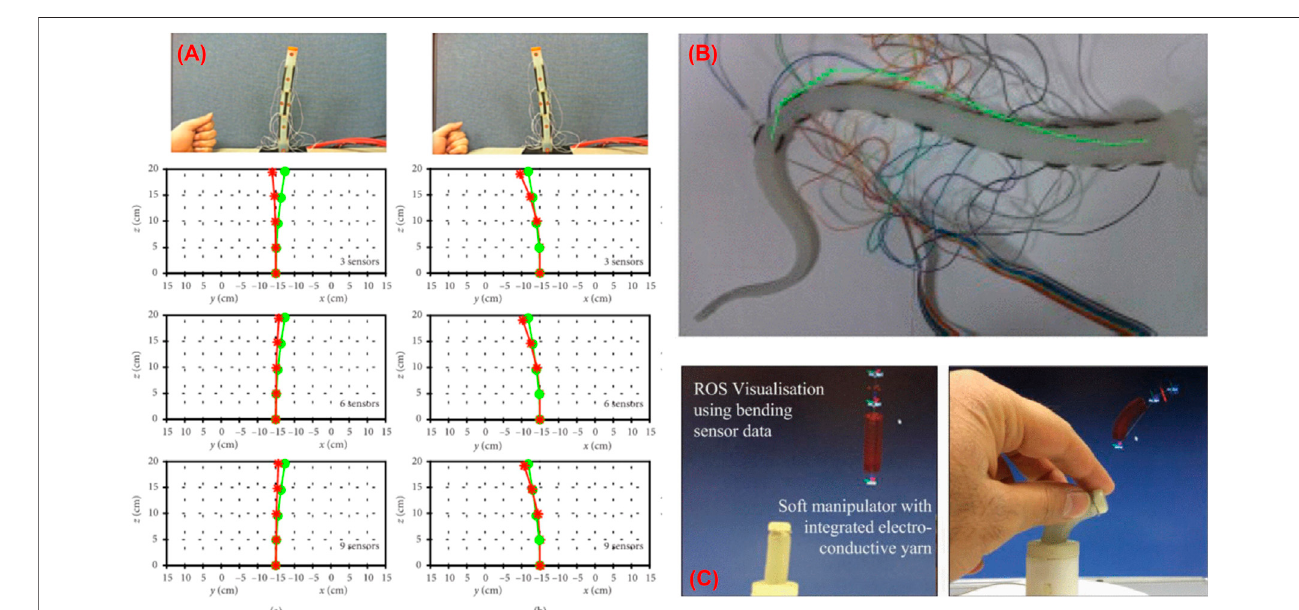
FIGURE 5 | Shape reconstruction of soft manipulators (A) using skin stretchable resistive sensor (So et al., 2021), (B) using conductive fabric (Cianchetti et al., 2012), and (C) using electro conductive yarn (Wurdemann et al., 2015).